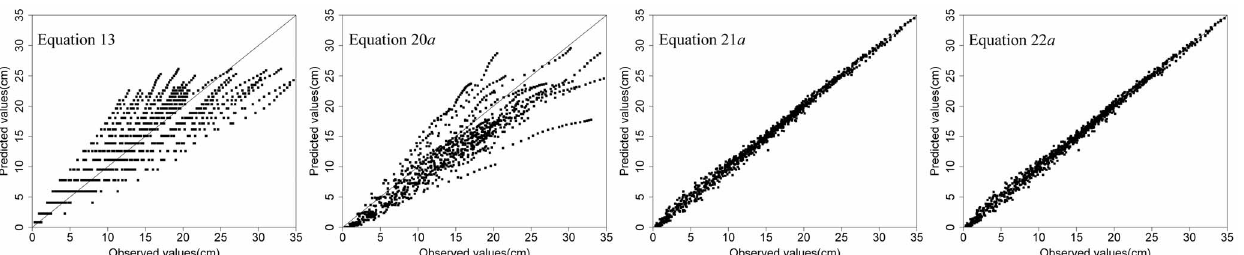
Figure 3. Scatter plot of fitted values against observed values of diameter growth of each model.